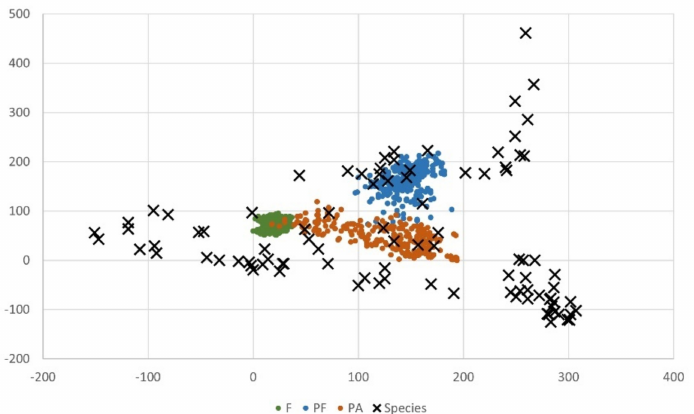
Figure 6. Share (mean ± 95% confidence interval based on 10 research plots of 100 m 2 ) of plant species consistent with Tilio-Carpinetum habitat in natural forests (F), manor parks adjacent to forests (PF), and manor parks not adjacent to forests (PA).